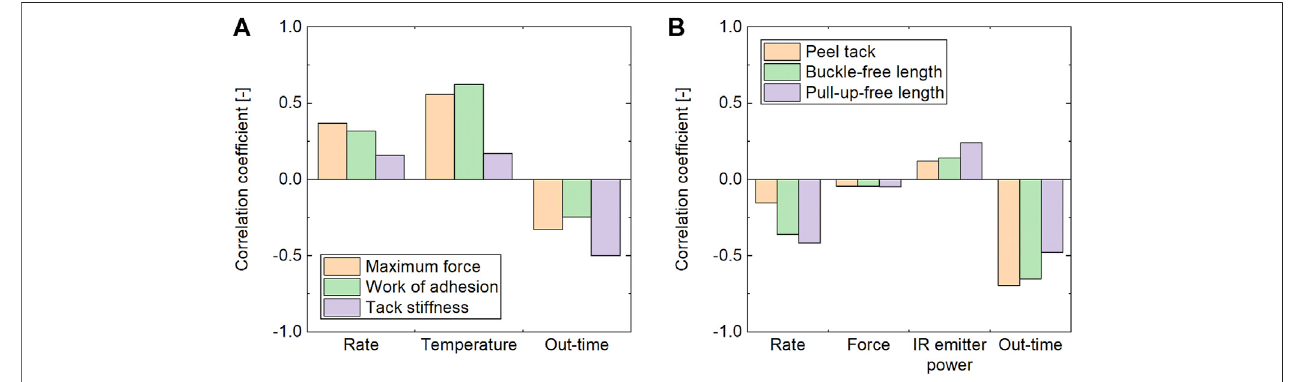
FIGURE 14 | Correlation coef fi cient of tack and lay-up related results of uncured IM7/8552 prepreg. (A) Probe tack. (B) Peel tack, buckles, and pull-up.